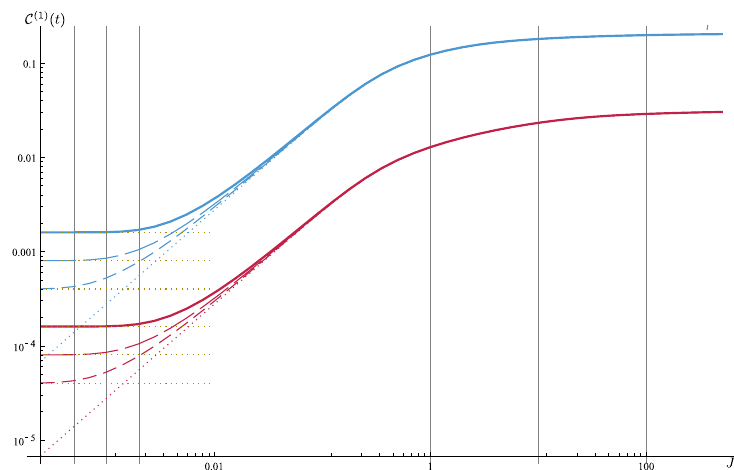
Figure 2. Exact C (1) ( t )- (cid:14)t relations in log-log scale. Red and blue lines correpond to b = 0 : 01 and b = 0 : 1 respectively. From solid to dashed, the curves correspond to t = 0 : 002 ; 0 : 001 and 0 : 0005, respectively. We can see the circuit complexity saturates around (cid:14)t (cid:24) t (gridlines), and the saturation value is approximately 8 Jbt (in yellow dotted lines). As reference, C (1) (0)- (cid:14)t relations are in dotted lines.